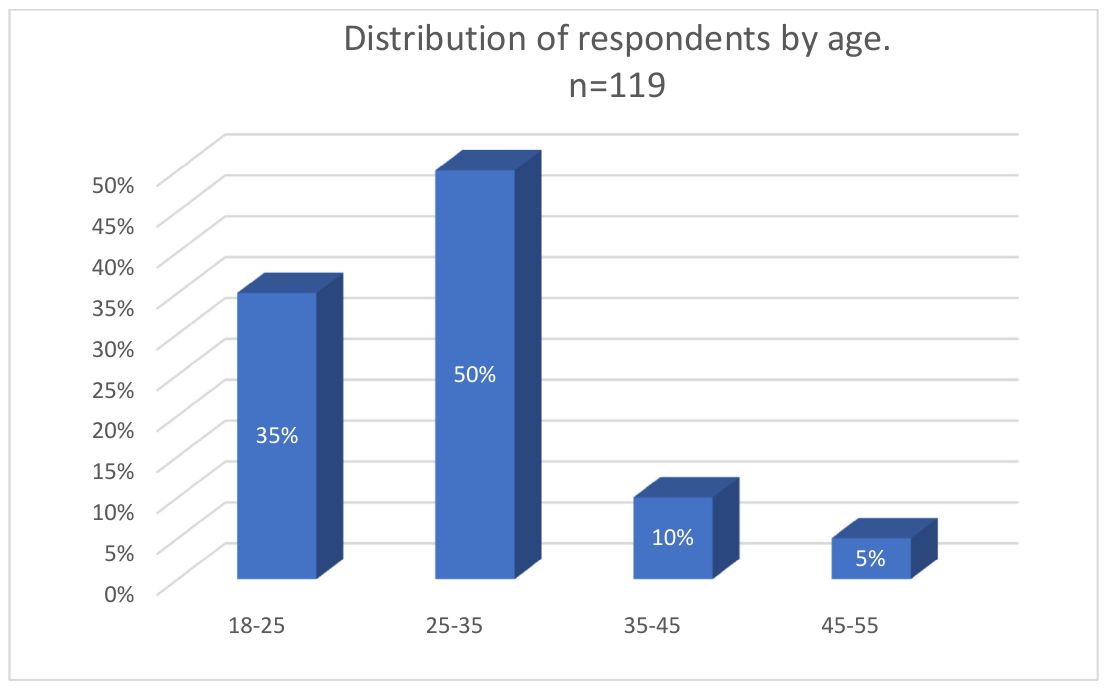
Figure 1. Distribution of respondents by age .